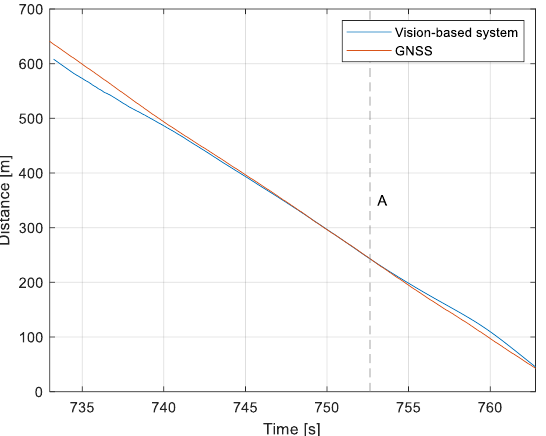
Figure 17. Distance from the runway: Flight no. 3 (marker A corresponds to the moment of recording the images in Figure 13.